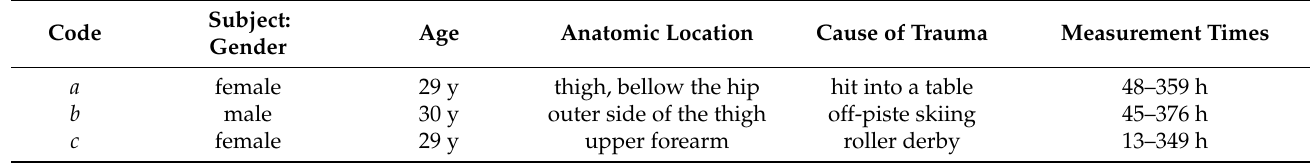
Table 1. Basic information on the included subjects and bruises.